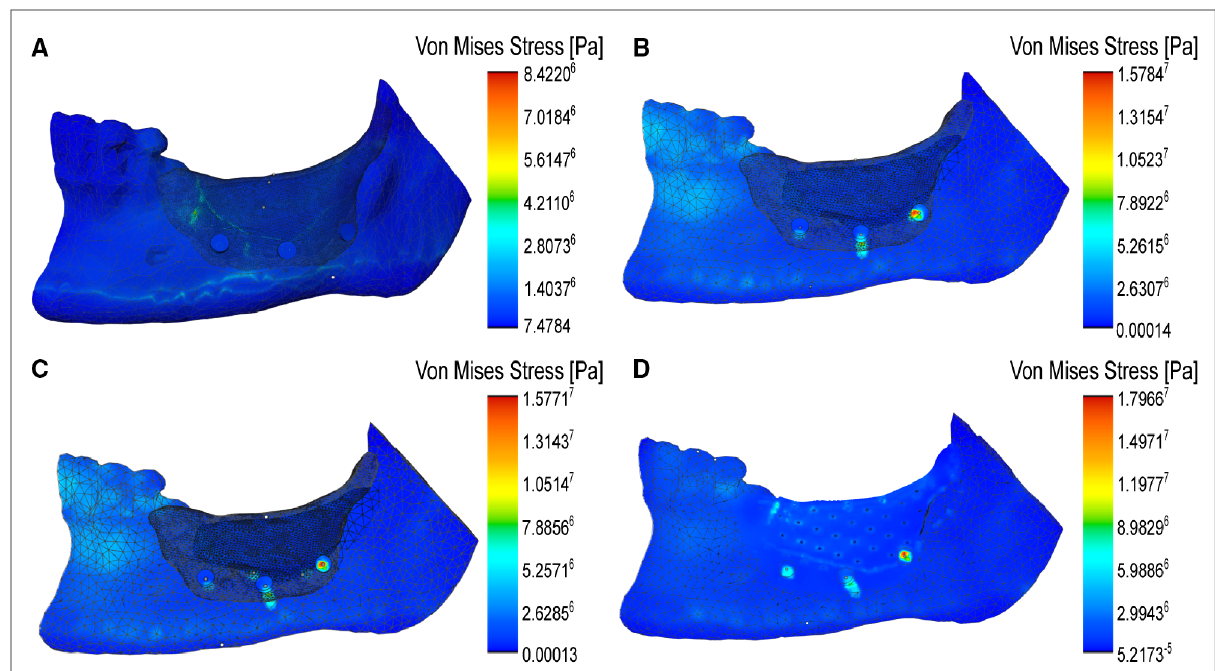
FIGURE 8 Modeling of the distribution of von Mises stresses on the covers under masticatory forces. ( A) Localized stress maxima on the thin cover. ( B ) Distribution of stresses on the compact cover with three facial anchoring screws. ( C ) Similar distribution of stresses over the cover with both facial and lingual screws. ( D ) Simulation of the von Mises stress distribution over the porous cover model with facial screws. In all situations, note the transfer of stress from the cover to the inferior body of the mandible, where the anterior tensile strains are